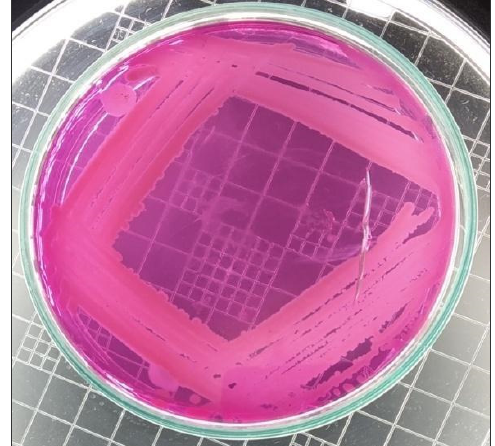
Figure 9. Growth of S. epidermidis on MSA.